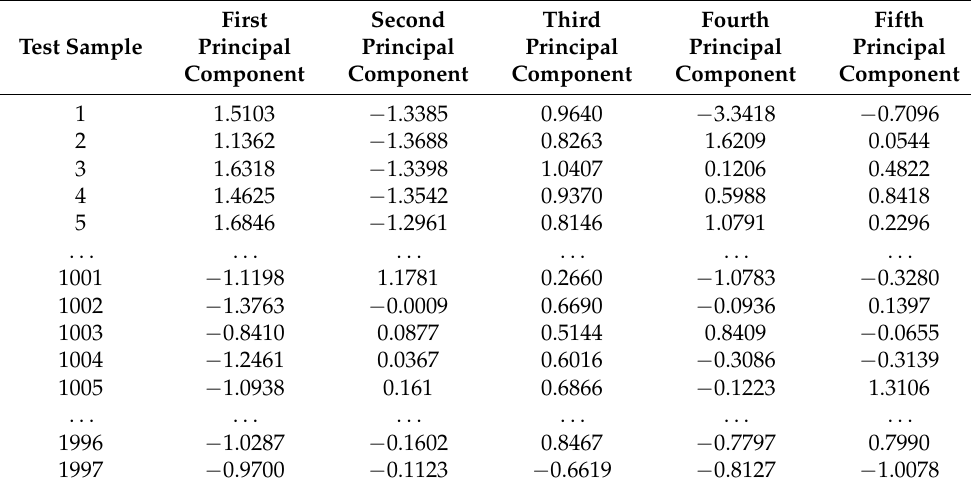
Table 9. Score of each principal